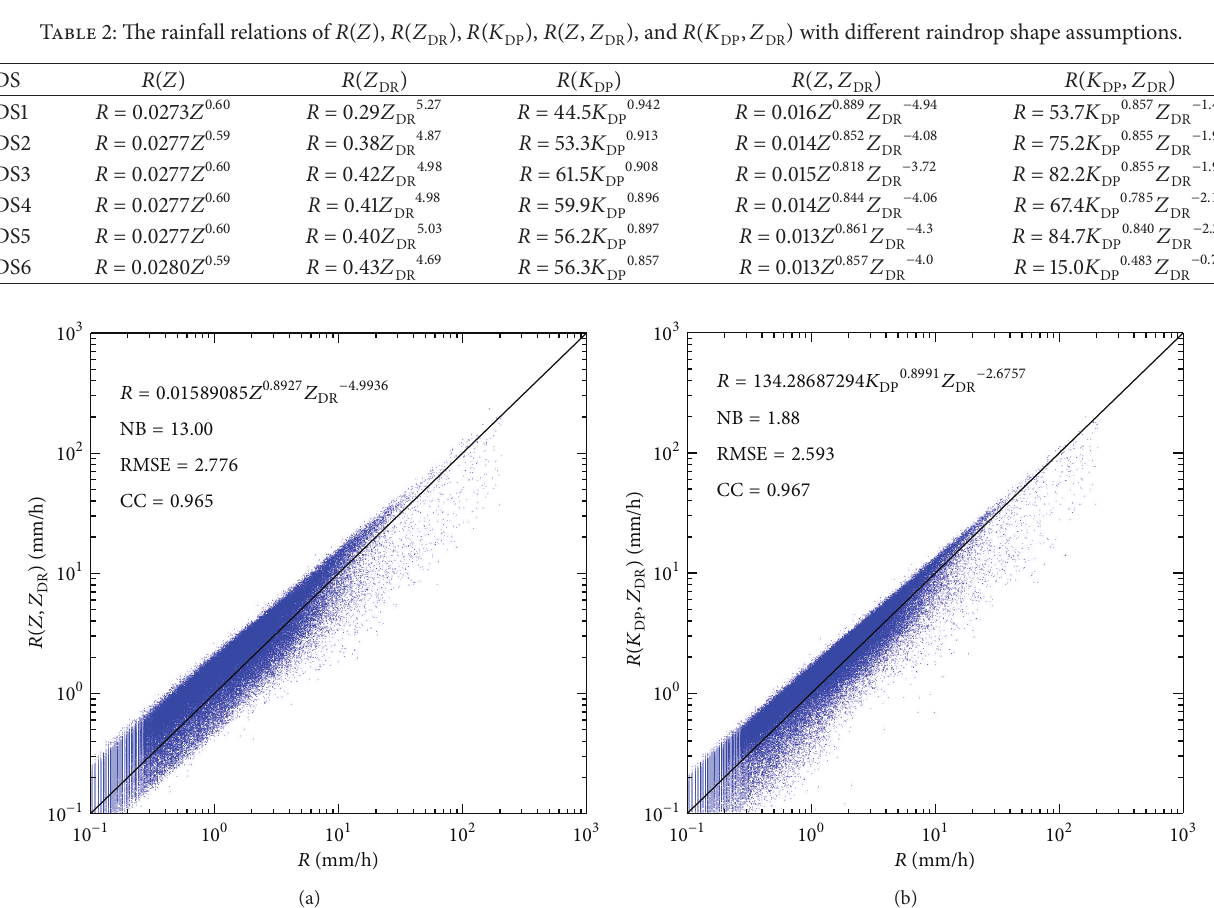
Figure 6: The scatter plots of rainfall obtained by DSDs and (a) 𝑅(𝑍,𝑍 DR ) and (b) 𝑅(𝐾 DP ,𝑍 DR ) using 𝑍 for DS3, 𝑍 DR for DS1, and 𝐾 DP for